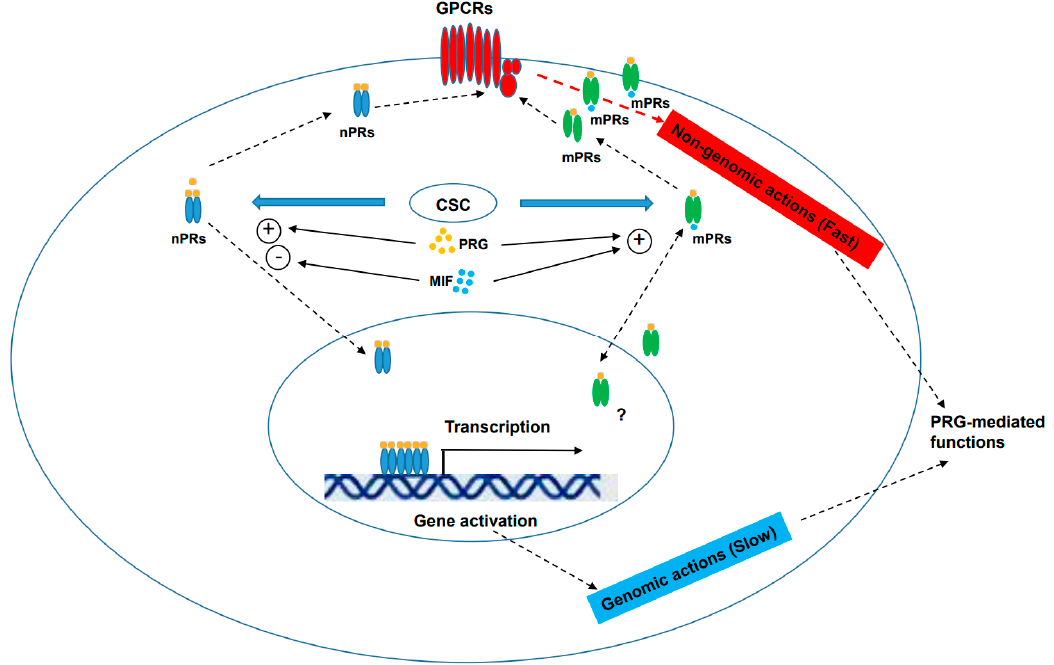
Figure 1. Signaling network bridge “crosstalk” among key players within CmPn signaling network. The diagram illustrates the relationship among PRG, nPR, mPR, CSC and the multiple ways PRG acts on classical nPRs and non-classical mPRs/PAQRs to influence cellular processes. We present that mPRs/PAQRs influence non-genomic actions, as well as possibly genomic actions, either through nPRs or independent of nPRs. Plus symbol indicates positive effects, while minus symbol imposes negative effects. In the figure, PRG, progesterone (gold-colored dot); MIF, mifepristone (light-blue-colored dots); nPRs (blue-colored), classic nuclear PRG receptors (blue-colored); mPRs, classic membrane PRG receptors (PAQRs, green-colored); CSC, CCM signaling complex; GPCRs: G-Protein Coupled Receptors (red-colored). Plus sign means positive effect, minus sign means negative effect and question mark indicates that the underlying mechanism is still unknown.